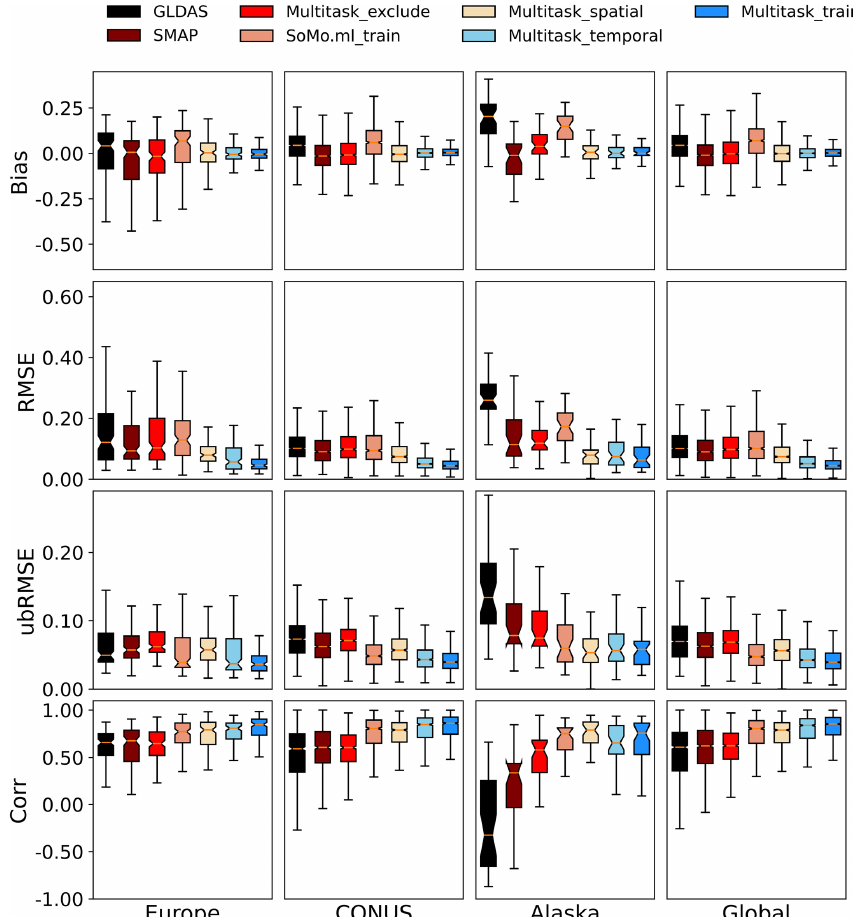
Figure 1. Comparison of model performances for different continents in data-rich regions. Models from left to right are ranked from lowest to highest global correlation. We plotted results for the training period, as well as temporal, spatial, and cross-continental tests. “Multi- task_exclude” means the cross-continent test: the models were tested on a continent, but sites from that continent were excluded from train- ing. The SoMo.ml product shown here was trained on all sites in all time periods, and thus it is most comparable to our “Multitask_train”